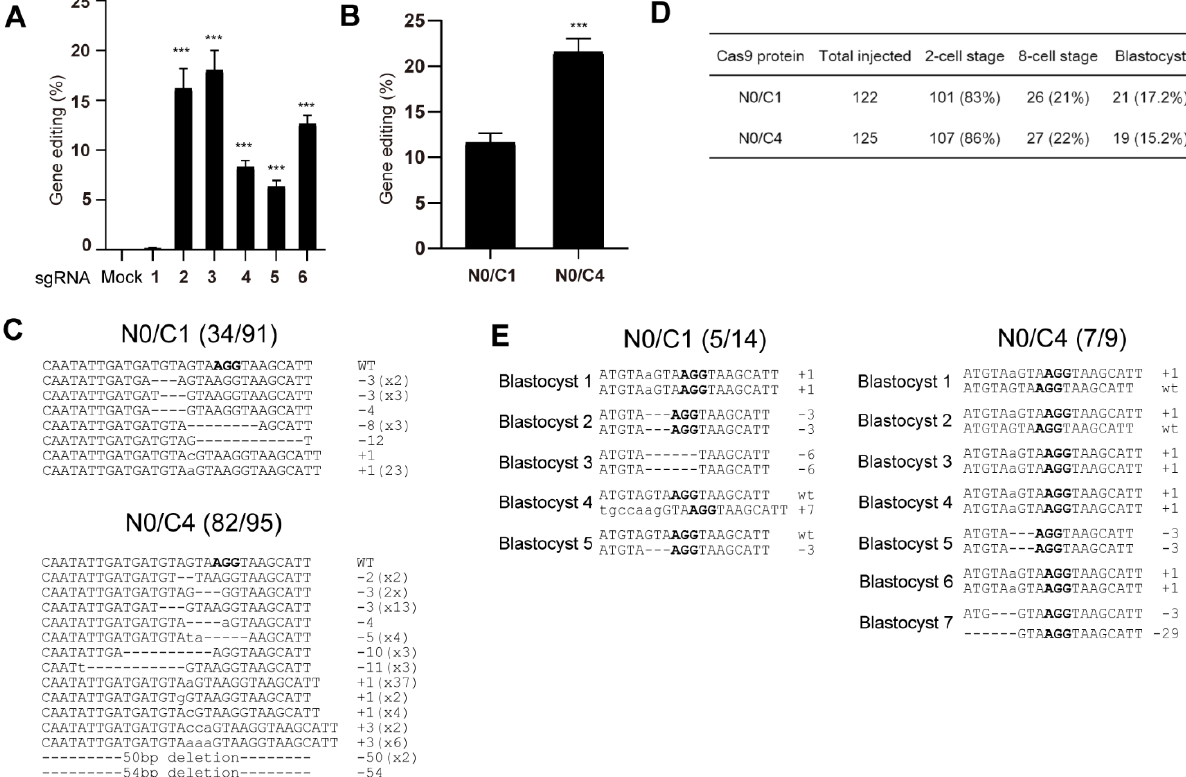
Figure 6. Genome editing of mouse embryos using microinjected N0/C1 and N0/C4 SpCas9 proteins. ( A ) Screening of PTEN-targeting sgRNA in mouse Hepa 1-6 cell line for genome editing. The